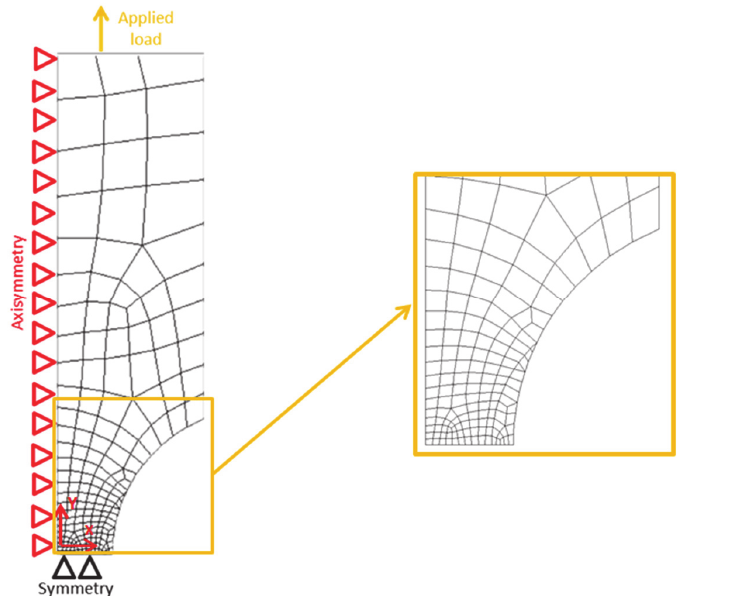
Figure 5: Typical mesh pattern of the finite element model near the notch tip and schematics of boundary